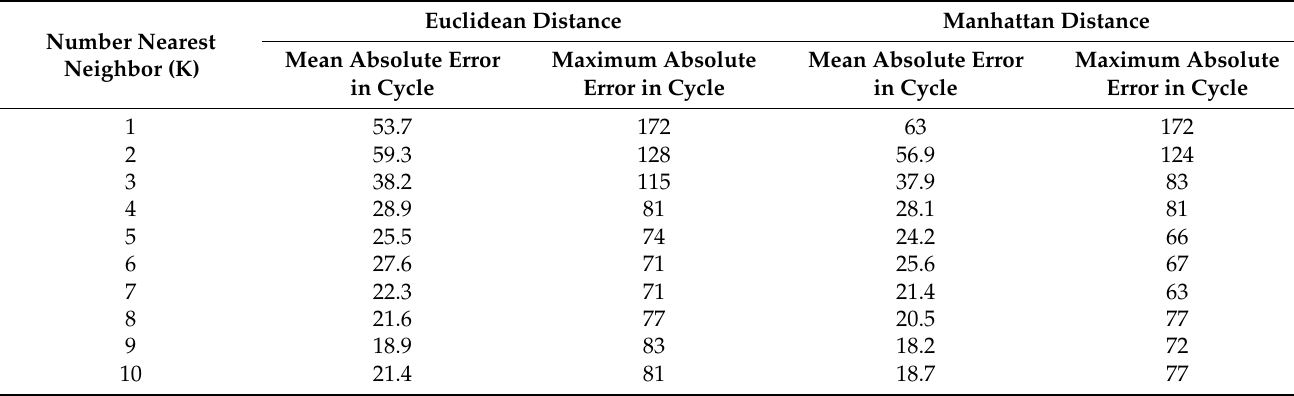
Table 19. Comparison results of FEM and KNN models on 576 training